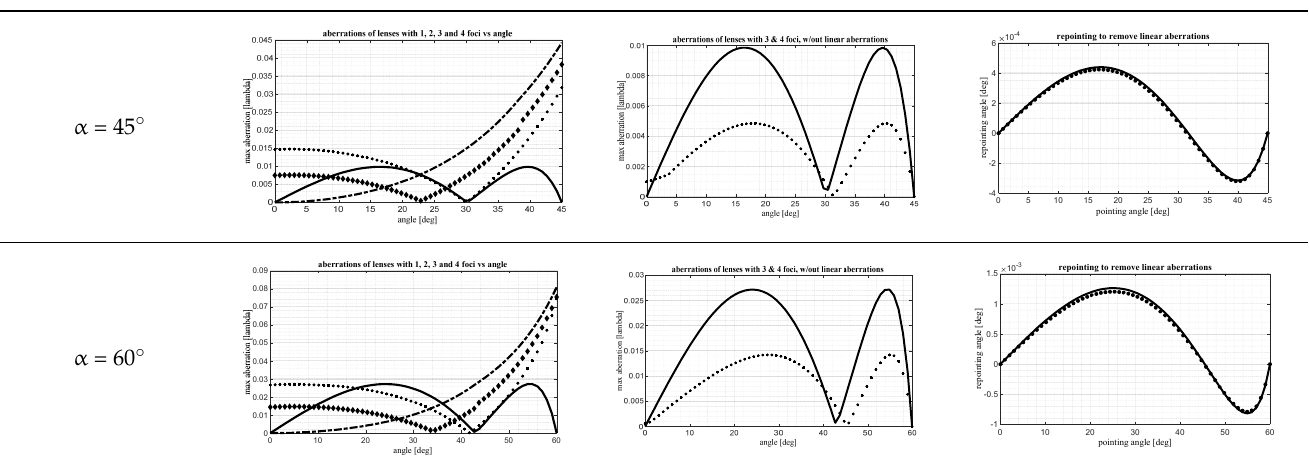
Table 4. Maximum aberrations normalized to the focal distance for discrete lenses having F/D = 1, M = 1 and ∼ 5 foci.